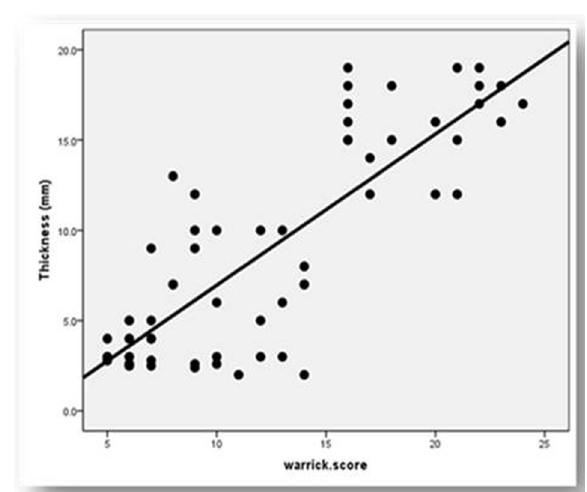
Illustrates the relation between Warrick score and pleural